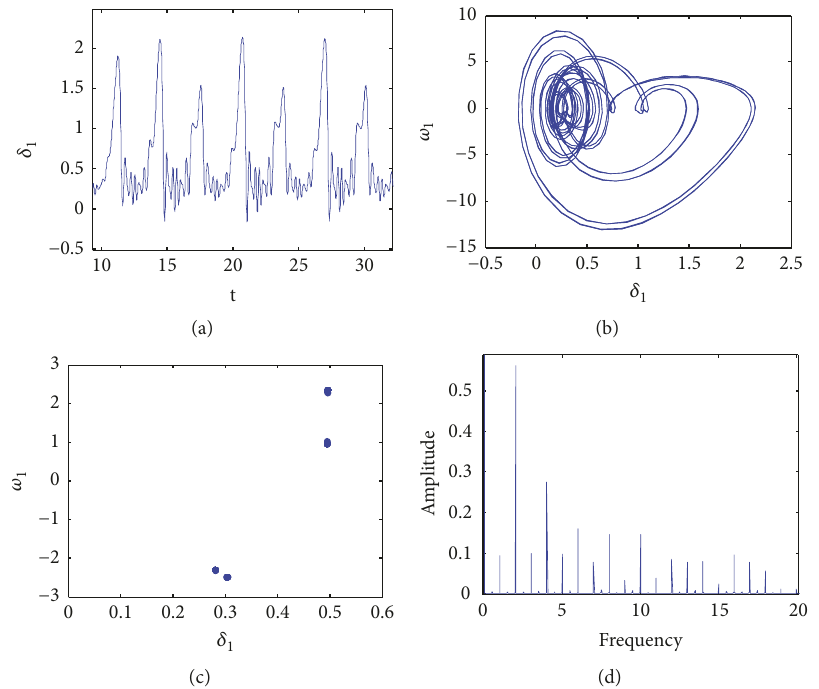
Figure 7: Period 4 motion ( 𝑉 𝐵1 = 0.637 ). (a) Time history. (b) Phase portrait. (c) Poincar´e map. (d) Frequency